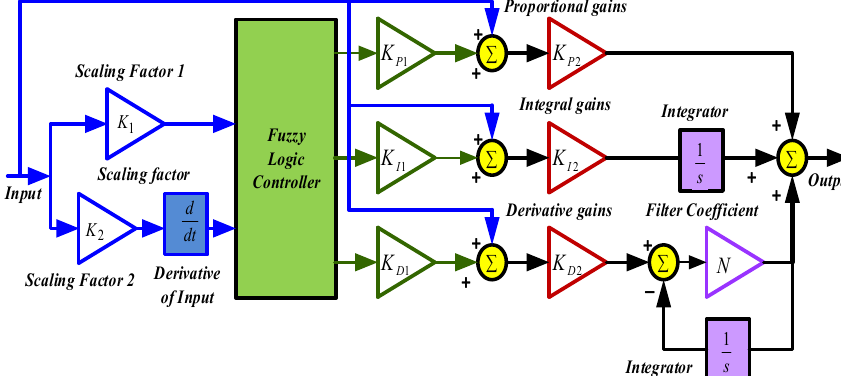
Figure 4. Combined fuzzy PID controller.